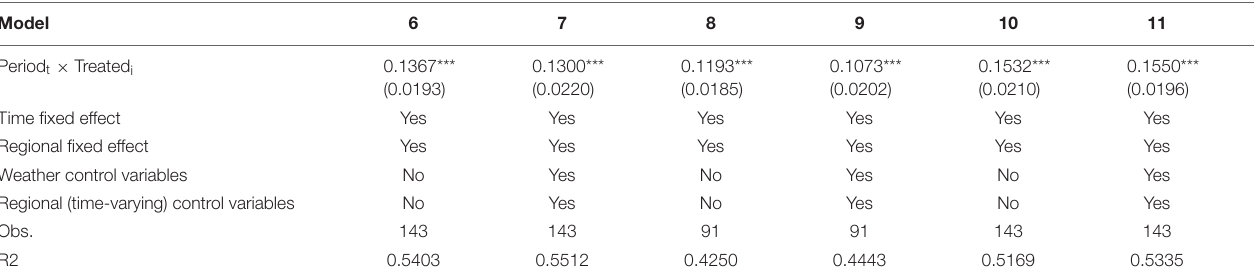
TABLE 4 | Testing under conditions of regional